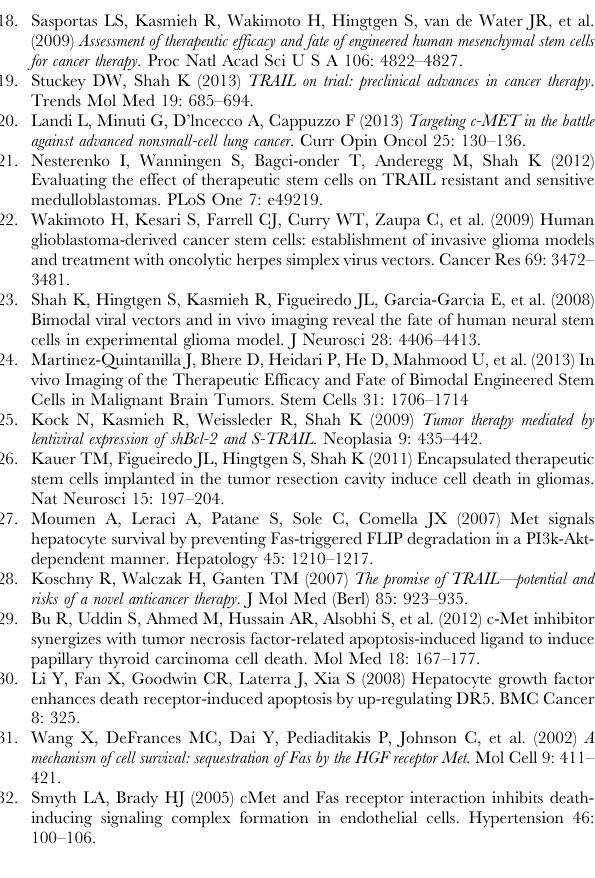
Figure S1 Induction of apoptosis by S-TRAIL treatment in MB cell lines. Effects of S-TRAIL treatment on UW426, DAOY and UW473 lines. Numbers in the respective quadrants indicate the percentage of cells presents in this area. In UW426 cells, the Annexin V positive cell population was significantly increased upon S-TRAIL treatment. * P , 0.05, ** P , 0.01. (TIF)